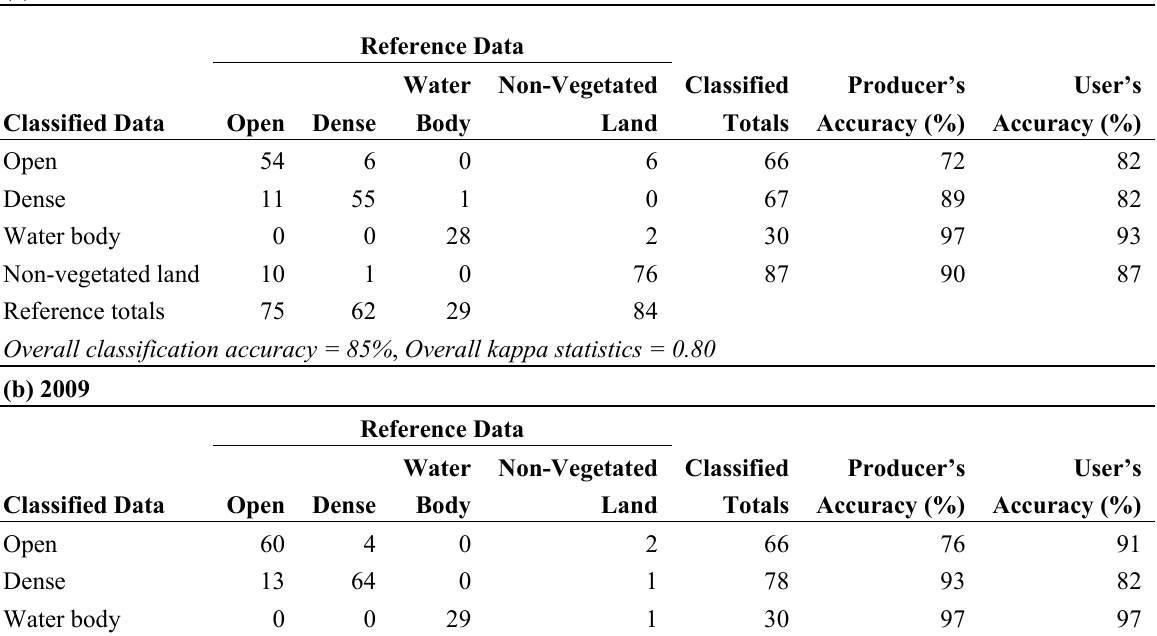
Table 3. Error matrix of the land cover maps derived from Landsat